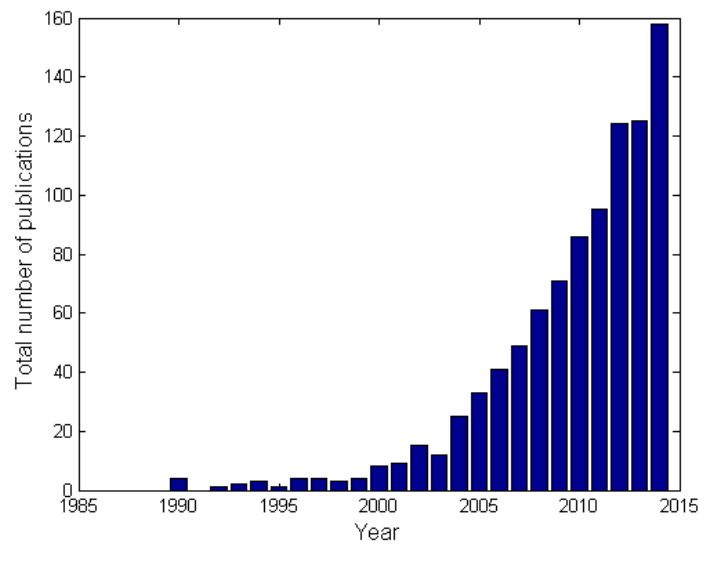
Figure 2. Evolution of the yearly number of publications since 1990 as indexed by Google Scholar using the following keywords: “metal foam”, “heat transfer” and “open-cell”.